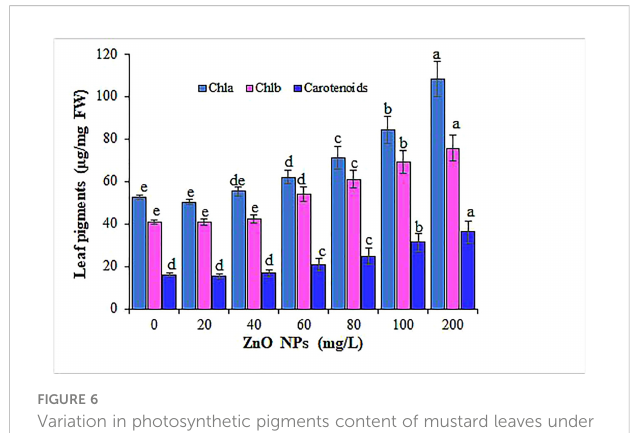
FIGURE 6 Variation in photosynthetic pigments content of mustard leaves under different concentrations of ZnO NPs. Values are mean standard error. Different letters denote signi fi cant differences (p ≤ 0.05) among concentrations for each